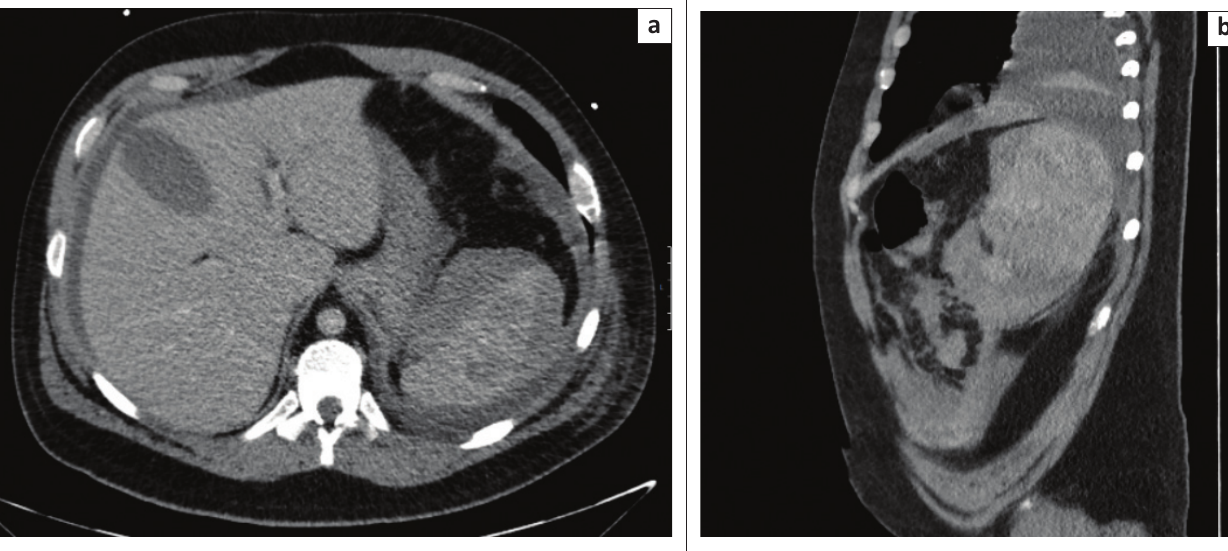
FIGURE 2: (a) Axial and (b) coronal images on day 10 post admission showing an enlarged spleen with an increased size of the subcapsular and intraparenchymal haematomas and free fluid surrounding the spleen and